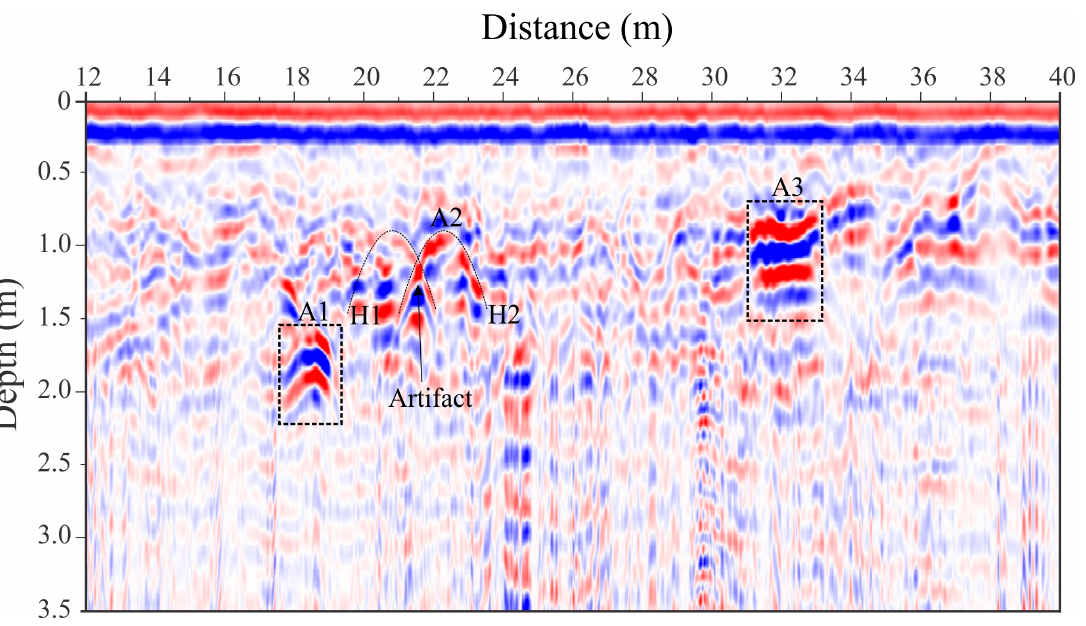
Figure 8. Segment of the GPR 1 profile of 200 MHz acquired in area 2. The black dashed rectangles highlight anomalies A1 and A3. Anomaly A2 is represented by hyperbole H2.